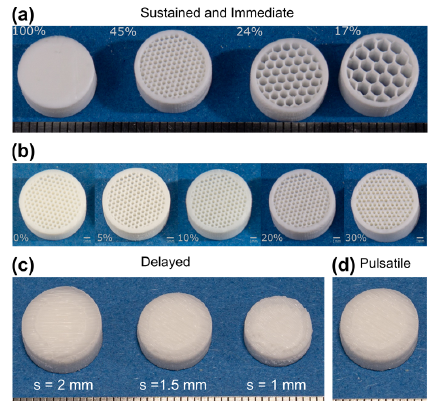
( b ) Figure 4. X ‐ ray powder diffraction curves. ( a ) Mixture of the two at 5%( w / w ), 10%( w / w ), 20%( w / w ) and 30%( w / w ). ( b ) Region of interest corresponding to the Fenofibrate characteristic peaks. 3.4. Printed Tablets By visual inspection, all tablets are well defined structurally. In Figure 5, it is possible to appreciate that both the immediate and sustained release tablets present a smooth sur ‐ face and are without appreciable defects, regardless of the printing infill used or drug content, suggesting that neither of these factors influence the printed outcomes in this aspect. Similar results can also be seen in the delayed and pulsatile release tablets where the top surface was also smooth except for a small indentation in correspondence of the out ‐